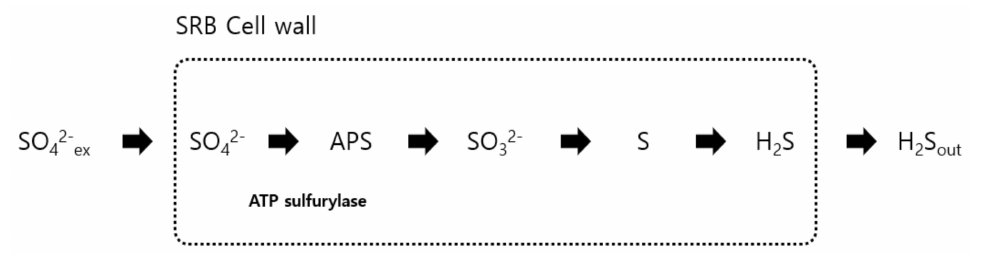
Figure 1. Sulfate reduction reaction by sulfate-reducing bacteria (SRB). APS is an enzyme and ATP sulfurylase (ATPS) catalyzes the first committed step in the sulfate assimilation pathway, the activation of sulfate prior to its reduction.